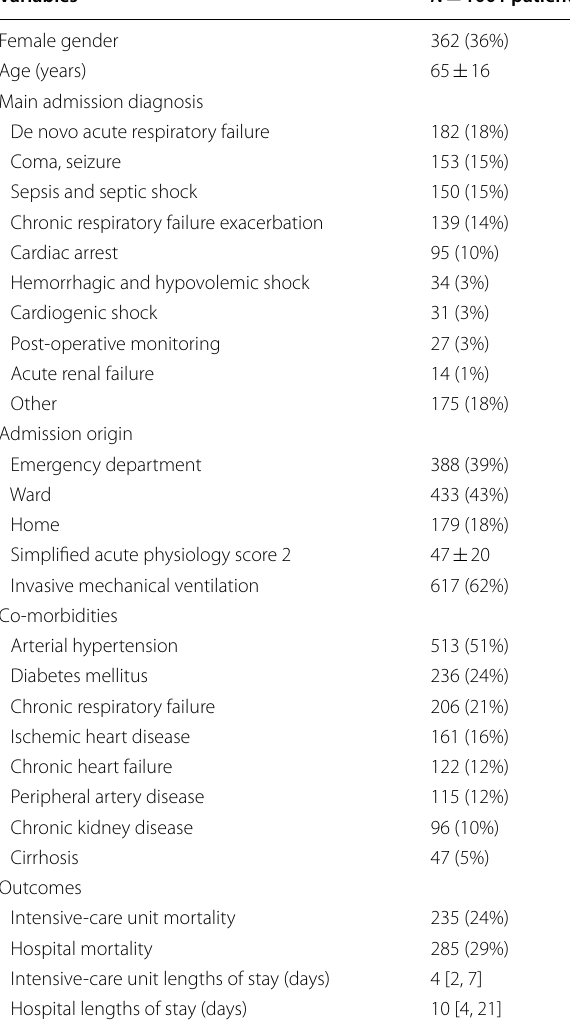
Table 2 Main patients’ characteristics Table 3 Nephrotoxic drugs most frequently prescribed among exposed